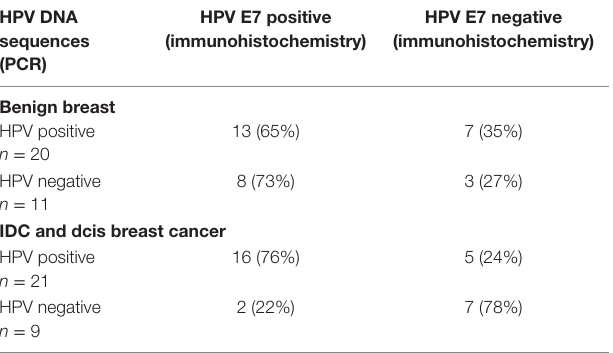
TaBle 4 | hPV e7 protein expression in high risk hPV-positive and -negative benign breast and invasive ductal carcinoma (iDc) and ductal carcinoma in situ (Dcis) breast cancer.